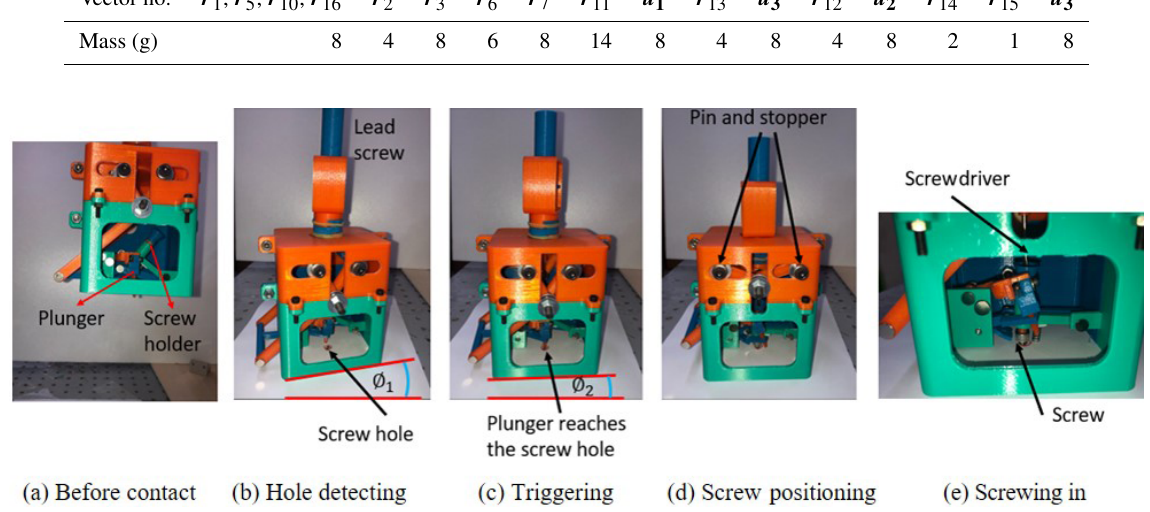
Table 4. Mass of links and pins. Vector no.